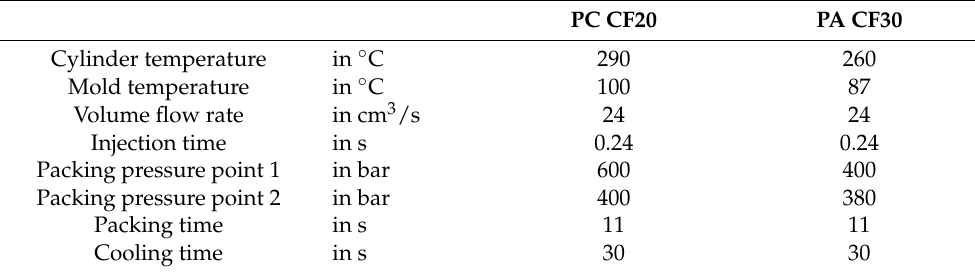
Table 3. Injection molding parameters.